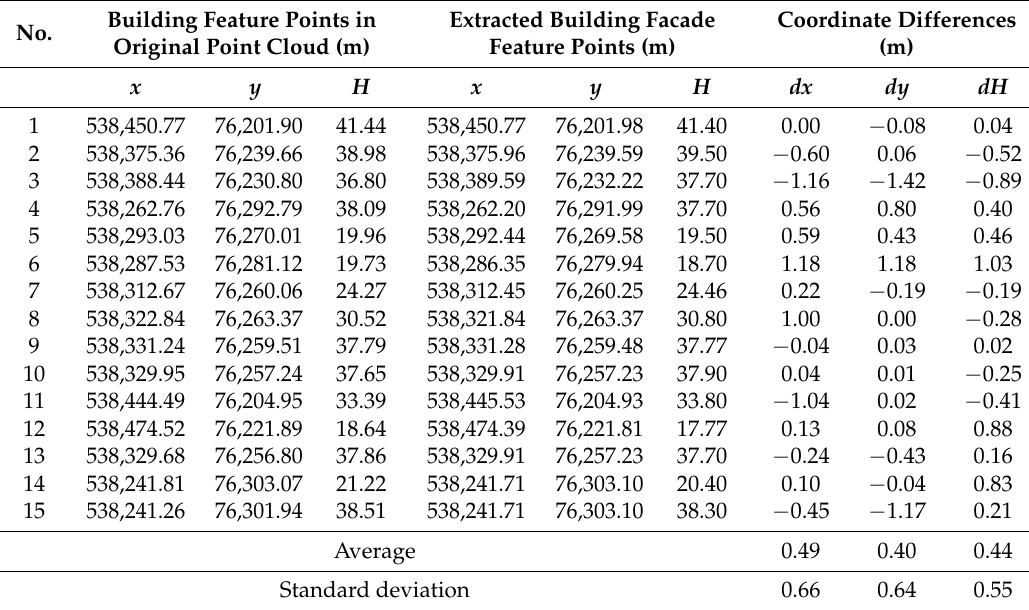
Table 1. Precision statistics of building façade pieces extraction.